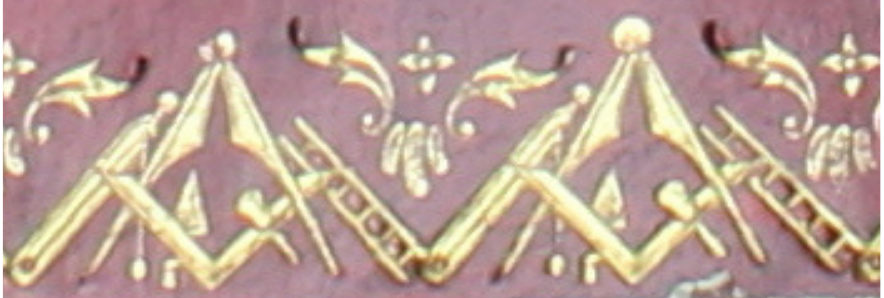
Fig. 12b. Holy Bible, containing the Old and Testament (Oxford, [1787]). Copyright and reproduced by permission of the Museum of Freemasonry, London. L63332. 28